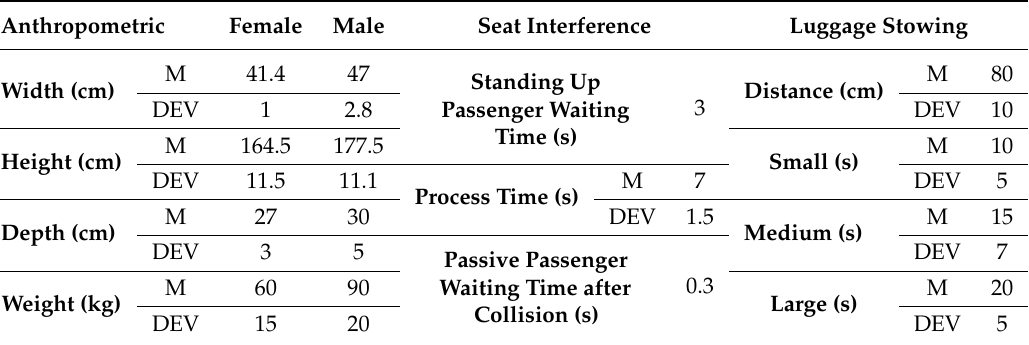
Table 2. Simulation properties (M: mean, DEV: